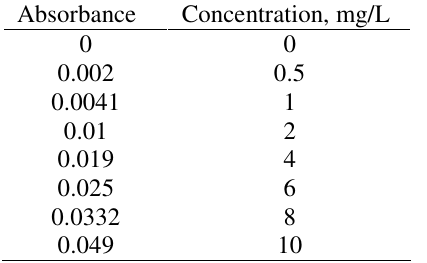
Table 1 . The calibration curve for Cu(II).